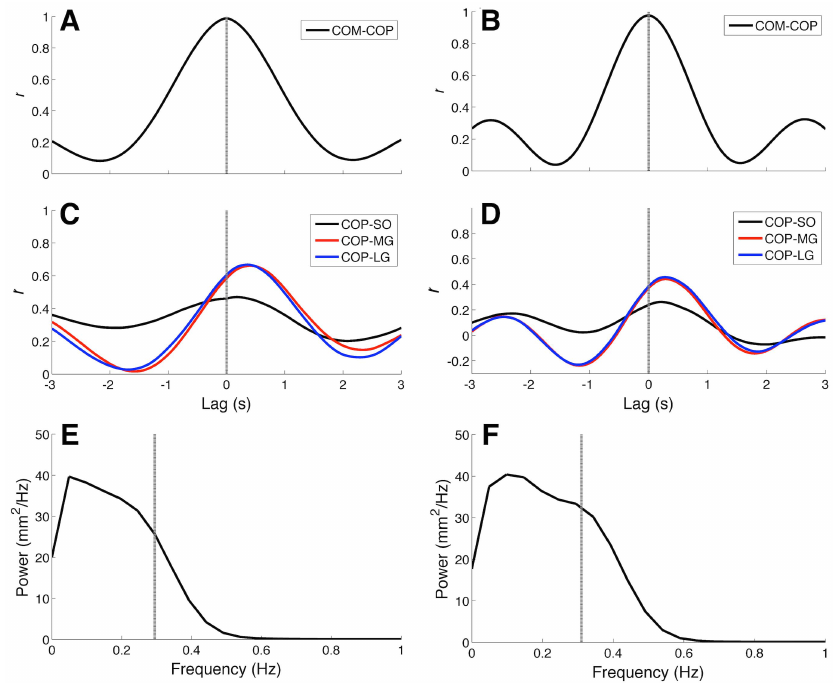
Figure 2. Cross-correlation functions and centre of pressure (COP) power spectra for typical simulations carried out on Model1 (graphs A, C, and E) and Model2 (graphs B, D, and F). (A-B) Cross-correlation functions between centre of mass (COM) and COP. Note that for both models, cross-correlation peaks occurred at zero lag (dashed lines). (C-D) Cross-correlation functions between COP and muscle electromyograms (EMGs). Black, red, and blue curves represent cross-correlation functions for Soleus (SO), Medial Gastrocnemius (MG), and Lateral Gastrocnemius (LG), respectively. Irrespective of the model structure, there was a lag of about 300 ms between COP and EMG envelopes from the three muscles. (E-F) COP power spectra. Dashed line represents the 50% power frequency ( F 50 ). It is noteworthy that for Model 2 there was a broader bandwidth in comparison to Model 1 .